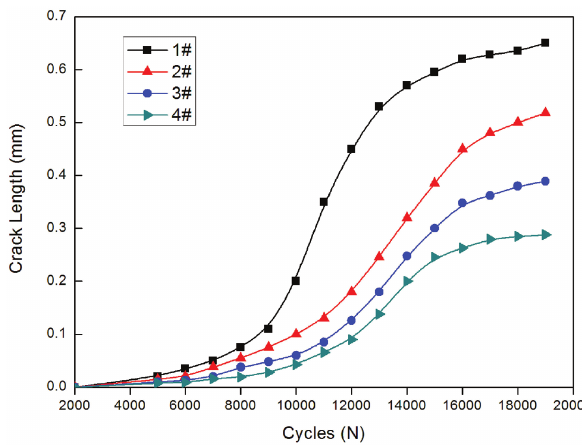
Figure 8: Thermal fatigue crack growth rate of Al-Si-Cu-Mg alloys with different treatment condition: (1#) as-cast state; (2#) solution treated; (3#) aging-treated at 180 ℃ for 2h; (4#) aging-treated at 180 ℃ for